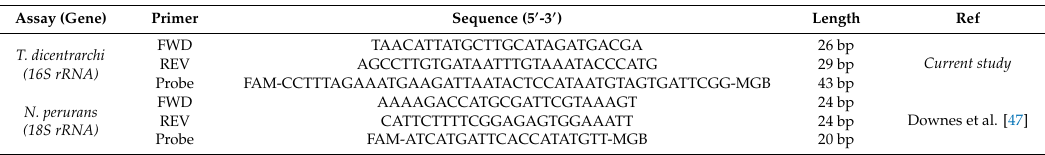
Table 1. Nucleotide sequences of primers and probes both designed and used in this study, for the real time PCR detection of T. dicentrarchi and N. perurans DNA